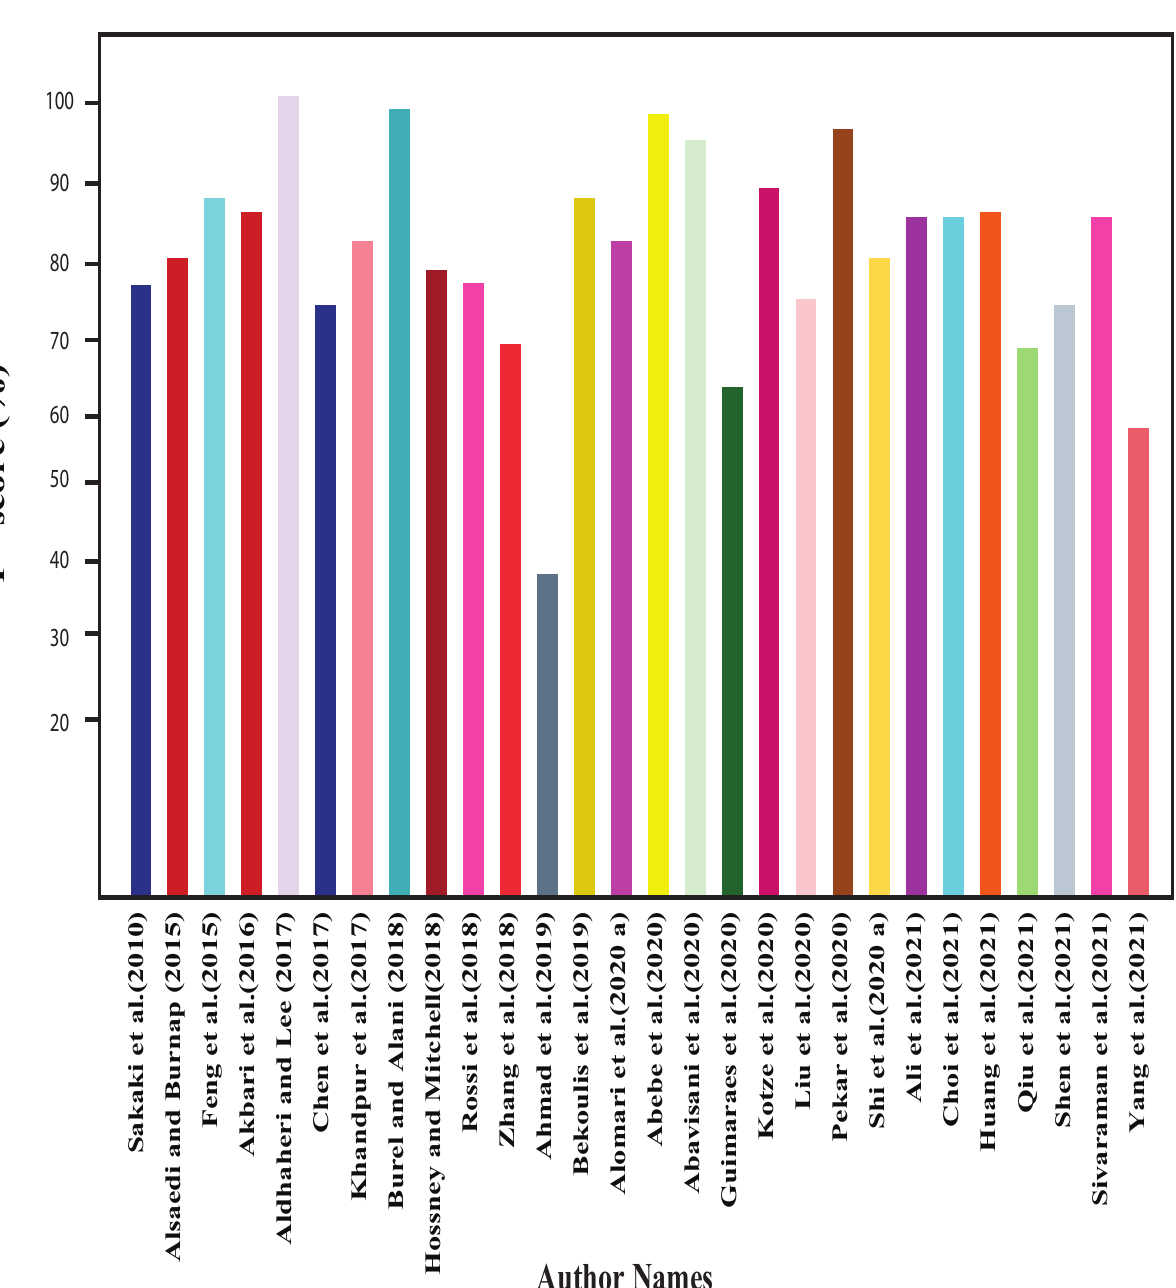
Figure 5. F-score-based performance comparisons of the articles. The height of each bar presents an article’s F-score, which is given in the Y-axis, and the X-axis shows the author’s name. Refs. [18–20,33,36,43,47,51,55,58–60,62–70,79,82,83,94,95,106,107] have used f-score for their perfor- mance analysis, and their values are presented using the bars in this